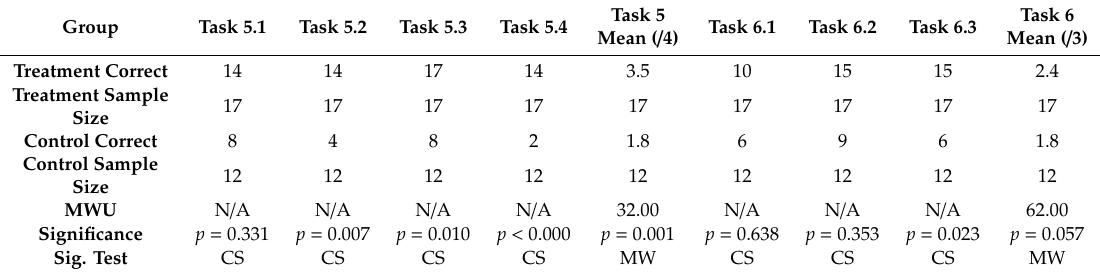
Table 4. Word frequency